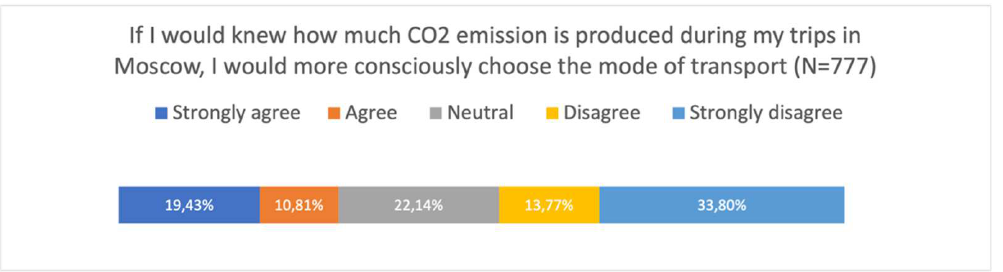
Figure 9. Future intention of respondents to manage their CO2 emission by their trips (N = 777).